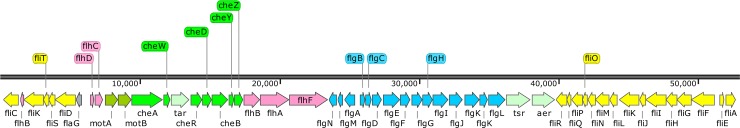
Structure and distribution of the flagellum biosynthetic region (PROKKA_00866–00919) in K. gyiorum SWMUKG01.The box arrows represent ORFs.